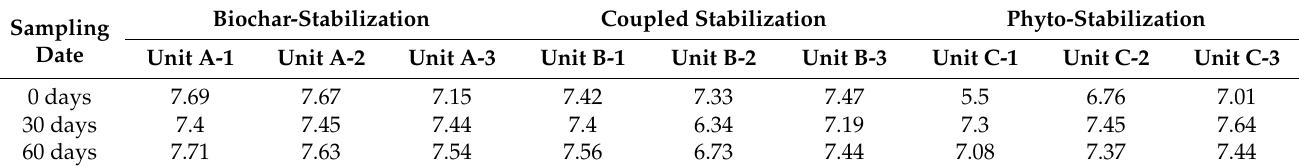
Table 2. Soil pH of all sampling units at 0, 30, and 60 days.